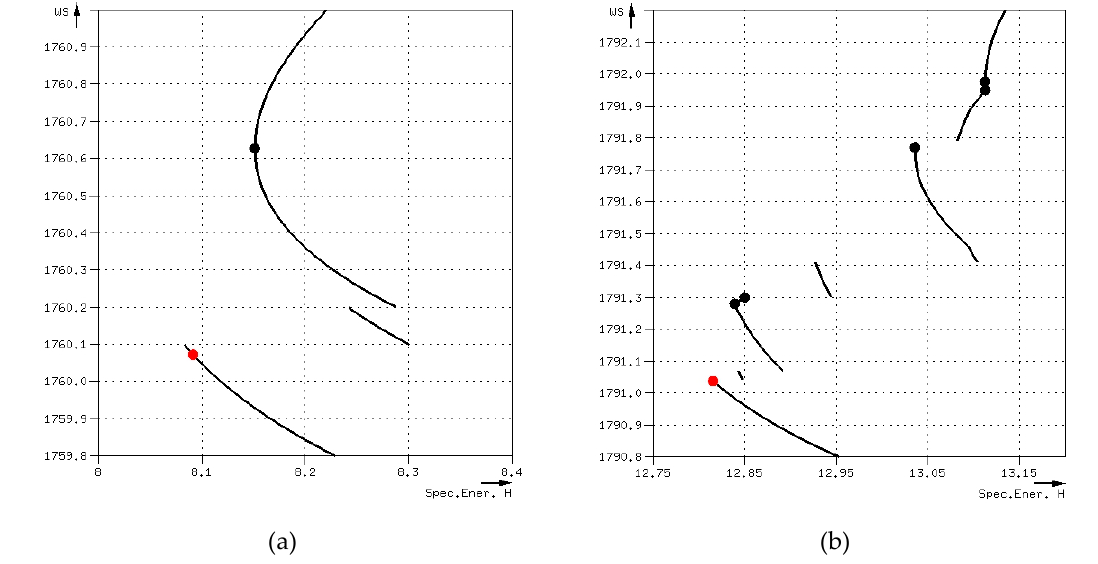
Figure 16. Dataset 3: Critical depths of case 4 ( a ) section 7 and ( b ) section 39. Figure 16 . Dataset 3: Critical depths of case 4 ( a ) section 7 and ( b ) section 39